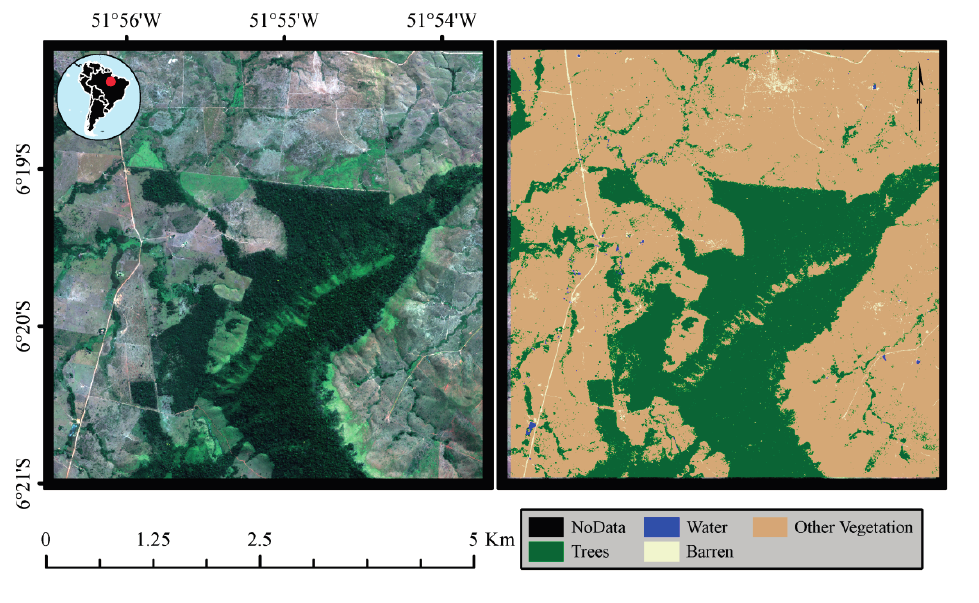
Figure 3. An example of a validation site located within the Northern Pará region of Brazil with very high resolution multispectral image and classified